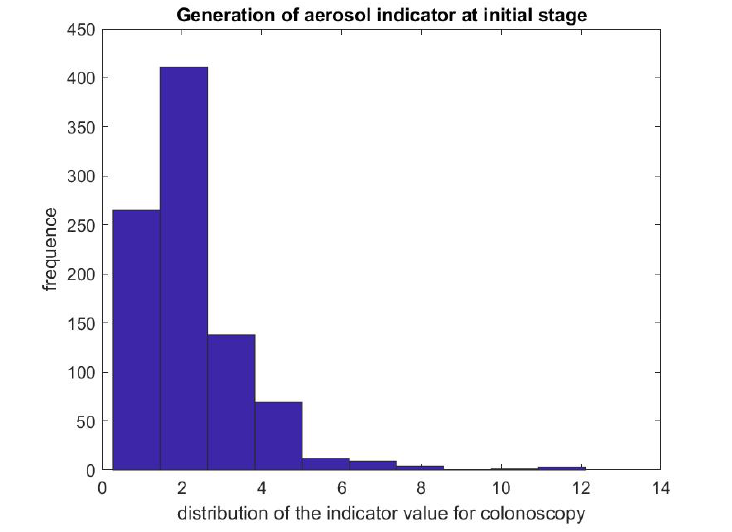
Figure 6. Indicator of aerosol generation for a colonoscopy during the first 5 min of the procedure. The figure represents the distribution of R col = D